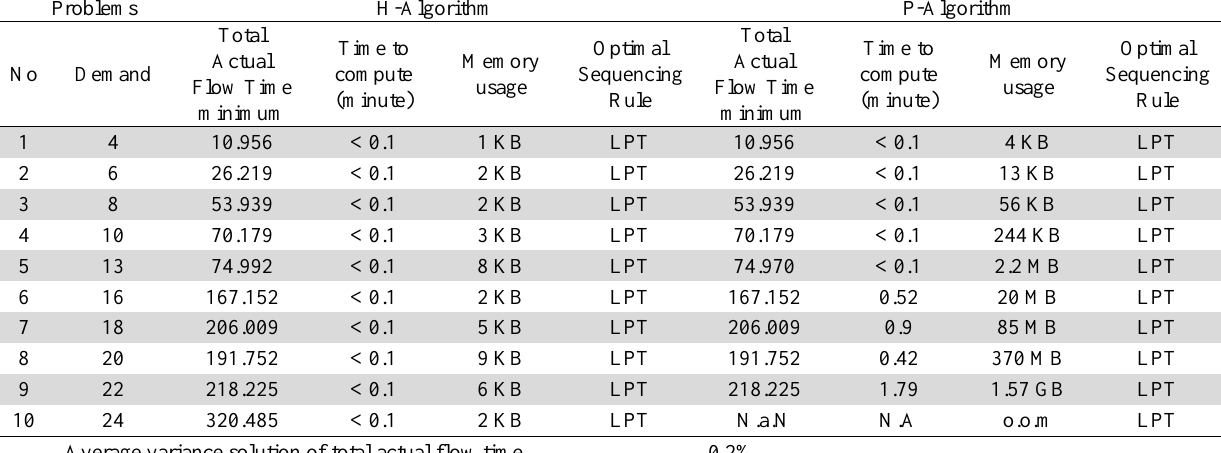
The result of comparison test between the H-Algorithm and the P-Algorithm Problems H-Algorithm